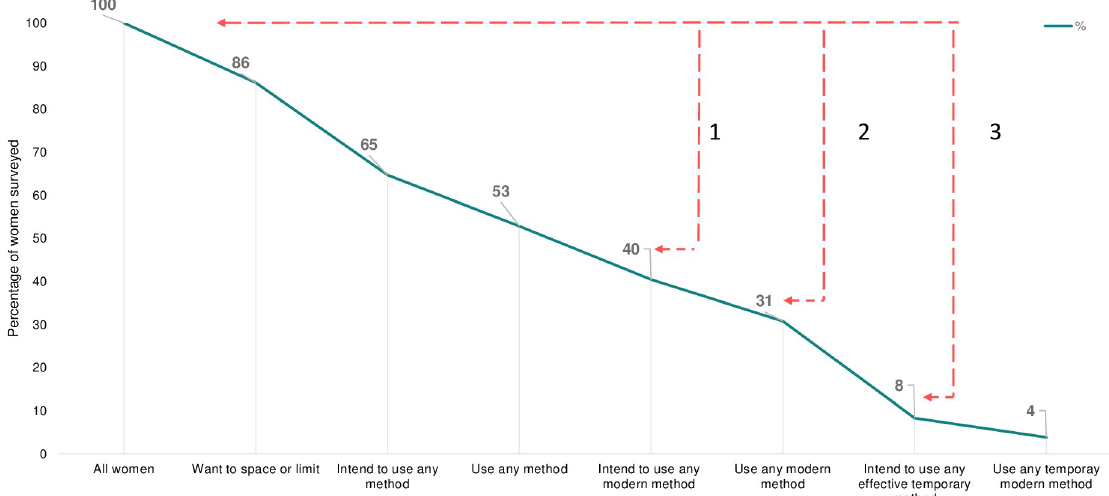
Fig 2. Family planning awareness-intention-use cascade. The figure shows descriptive analysis of 2016 DLFPS (n = 13,182 married women ages 15–49). Despite high awareness of modern methods (99% of women are aware of modern contraceptives and 94% are aware of modern temporary ones), there are large gaps between awareness, intention, and use. As shown, there is a 46% drop (bracket 1) between women who want to space/limit and women who to intend to use a modern method, a 55% drop (bracket 2) between wanting to space/ limit and using any modern method, and a 78% drop (bracket 3) between wanting to space/limit and intending to use any modern temporary method. “Want to space” is defined as the response “not wanting to have child now/soon”. Any modern method includes female/male sterilization, IUCD, OCP, ECP, injectable, condom, standard days method, and LAM (note that % of standard days method and LAM are minimal). Any modern temporary method includes IUCD, ECP, OCP, and injectable. Only non-users were asked about intention to use methods in the DLFPS, hence, added current users to group because we assume that current users had